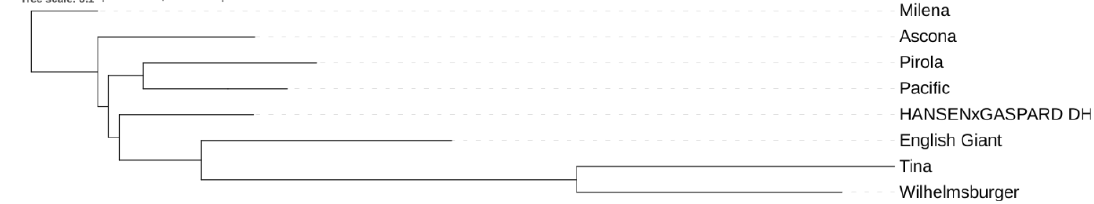
Figure 1. Phylogeny analysis of eight winter type and blackleg resistant B. napus cultivars; Ascona, English Giant, Hansen × Gaspard, Milena, Pacific, Pirola, Tina and Wilhelmsburger.